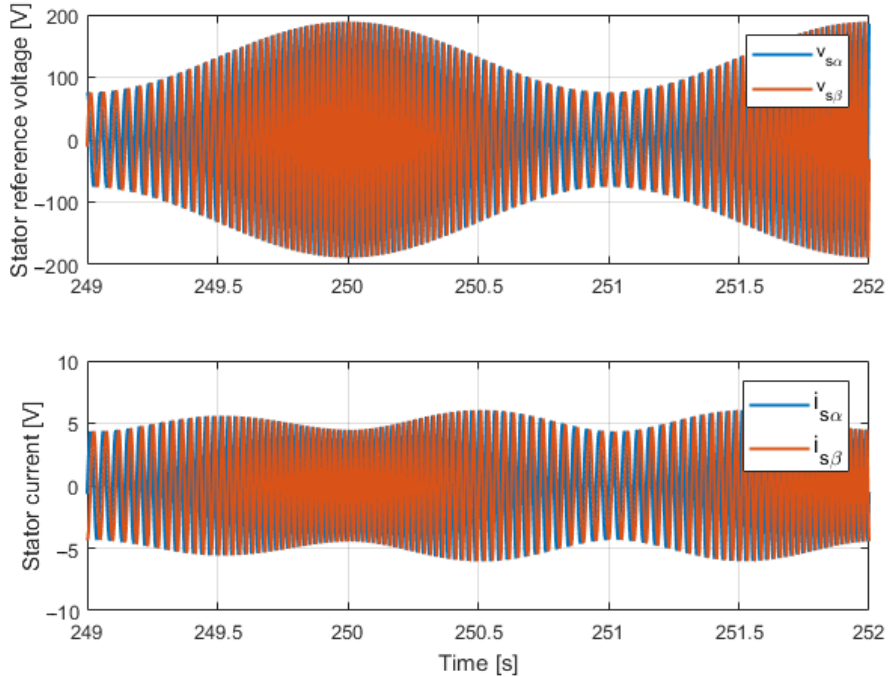
Figure 11. 2 s of wave-forms with harmonic insertion for mechanical parameters